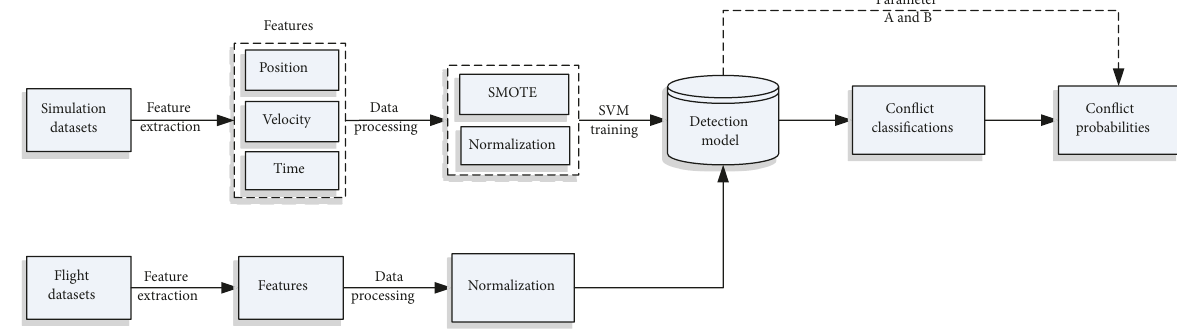
Figure 2: Probabilistic conflict detection by SVM flow